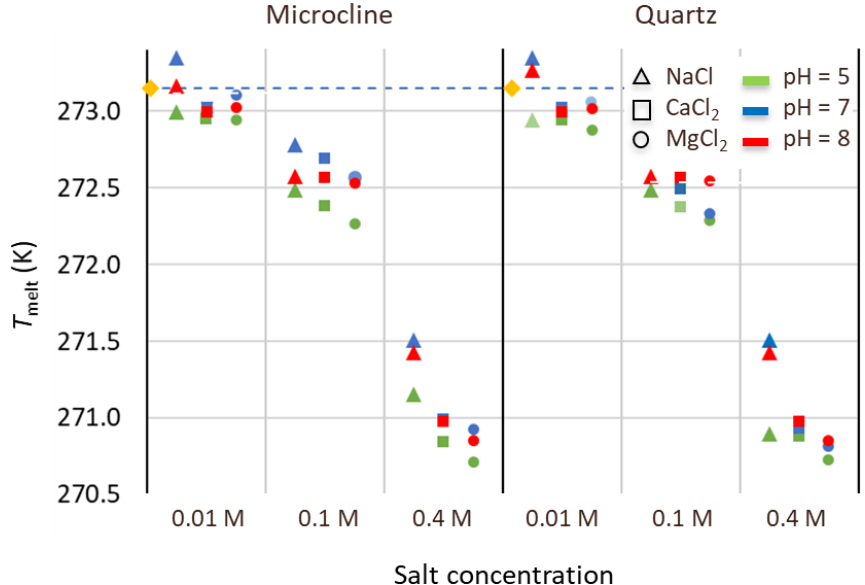
Figure 9. Melting points of microcline and quartz suspensions in aqueous solutions of the salts: NaCl (triangles), CaCl 2 (squares), and MgCl 2 (circles) at three salt concentrations (0.01, 0.1, and 0.4M) and for three pH values: pH 5 (green), pH 7 (blue), pH 8 (red). Reference measurements with microcline and quartz suspensions (yellow diamonds) in Milli-Q water yield the melting temperature of pure water (dashed